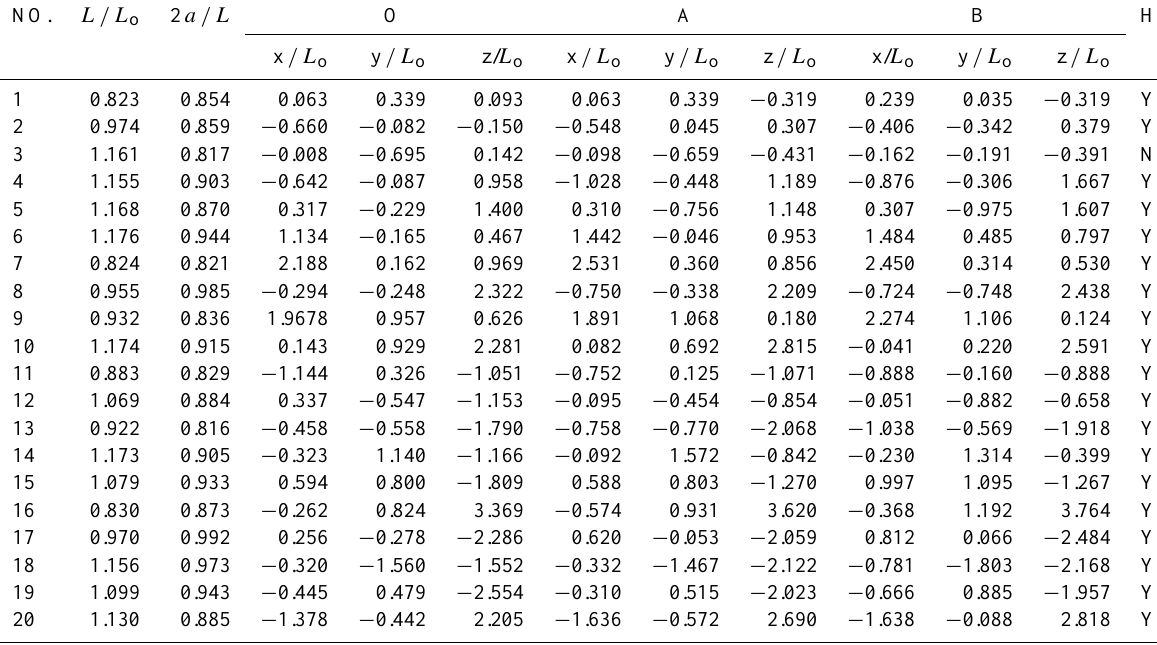
Table A1. Geometric parameters of the hexagonal aggregate with 20 monomers. All length parameters are normalized by L o , the average monomer length. The last column indicates whether the monomer has a hollow structure as shown by Fig. 1 (“Y” indicates “yes”, and “N” indicates “no”). Note, only the third monomer does not have a hollow